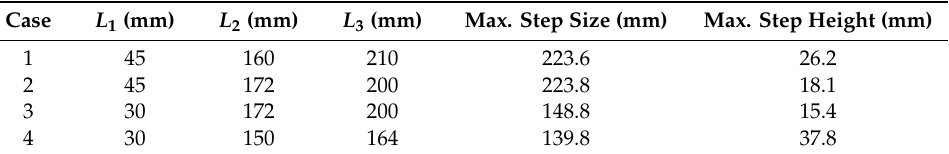
Table 1. Four sets of design data for L 1 , L 2 , and L 3 .